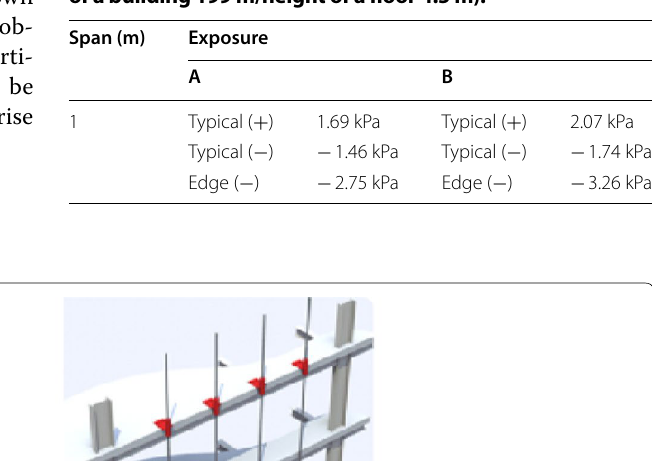
Table 1 Comparison of design wind pressure between Seoul and Busan, (a) Seoul (importance factor 1.0/height of a building 199 m/height of a floor 4.5